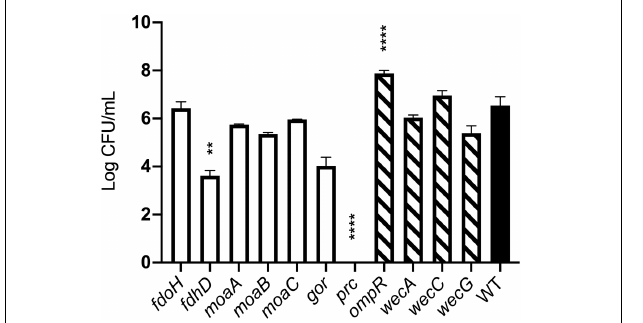
FIGURE 7 | Effect of model honey B on strains deleted for individual genes. Strains containing deletions of genes previously identified as “loss of fitness” (plain bars) and “gain of fitness” (hatched bars) were treated with model honey B for 24 h before plating to measure survival. **** p ≤ 0.0001, ** p ≤ 0.005. The graph shows average ± standard deviation ( n = 3; biological